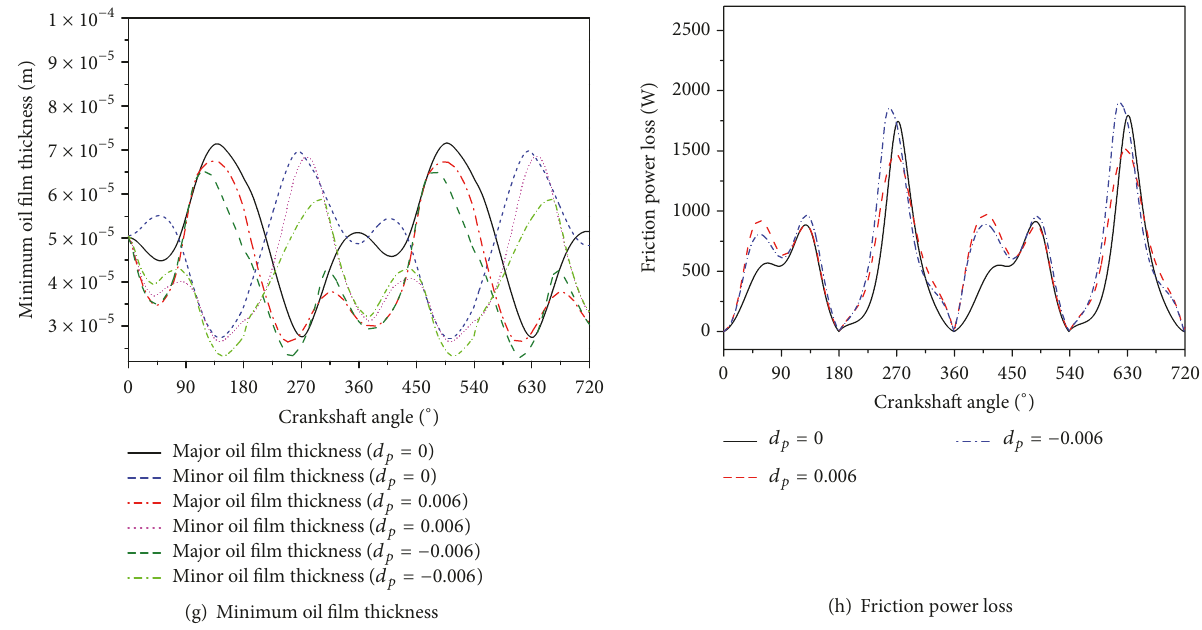
Figure 19: Effect of piston pin offset on skirt lubrication performance.